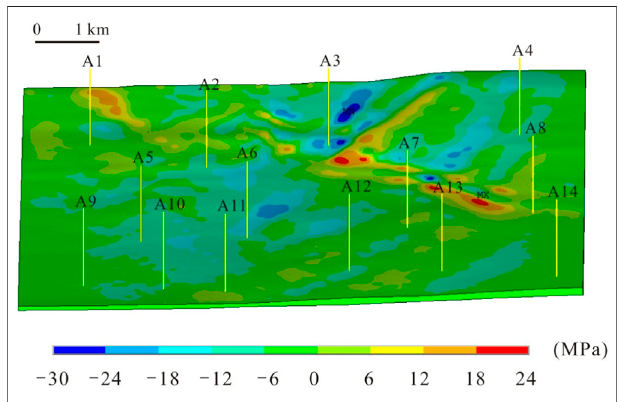
FIGURE 14 | Planar distribution of shear stress in the target